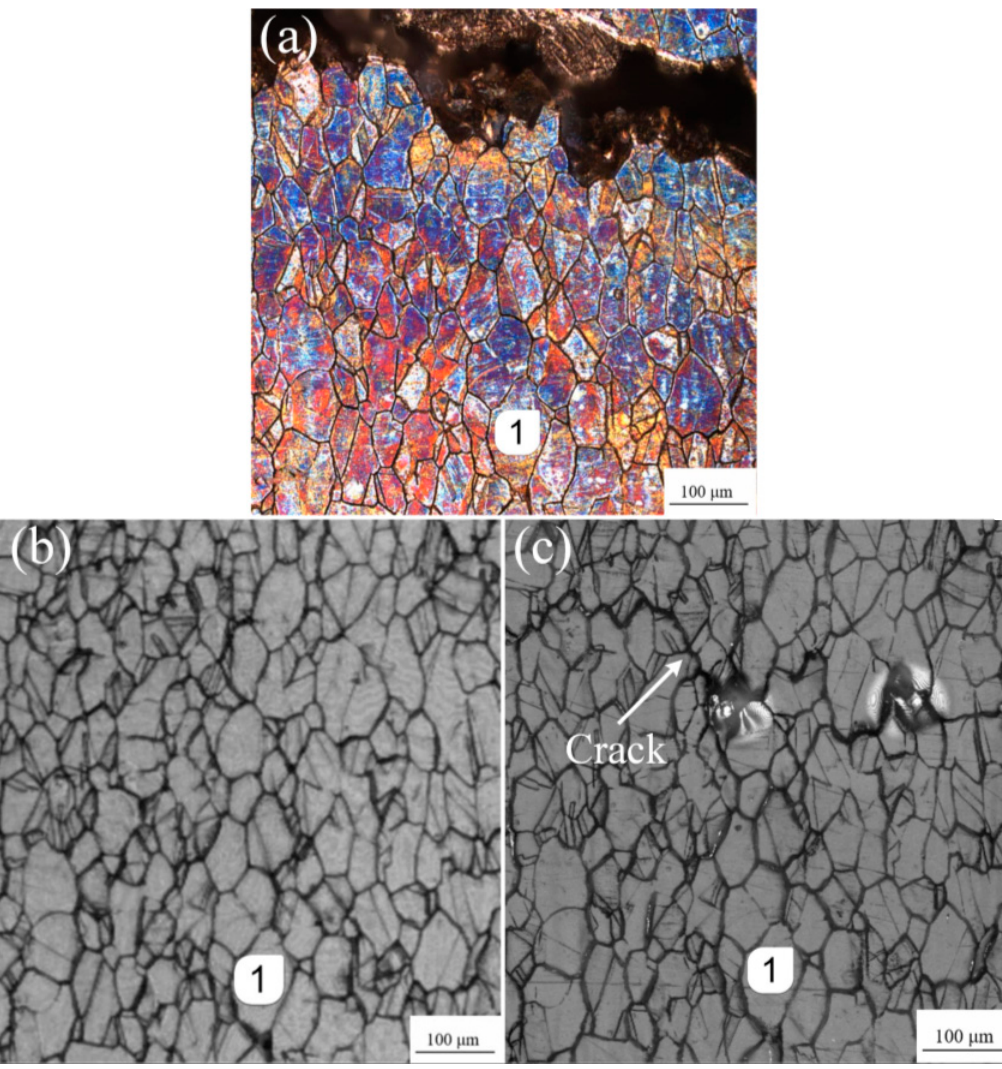
Figure 12. Side view of the fracture and corresponding replica film (etched constant load specimen): ( a ) the fracture side view of the etched surface specimen; ( b ) the photograph of the replica films before testing; ( c ) the photograph of the replica films near the fracture.